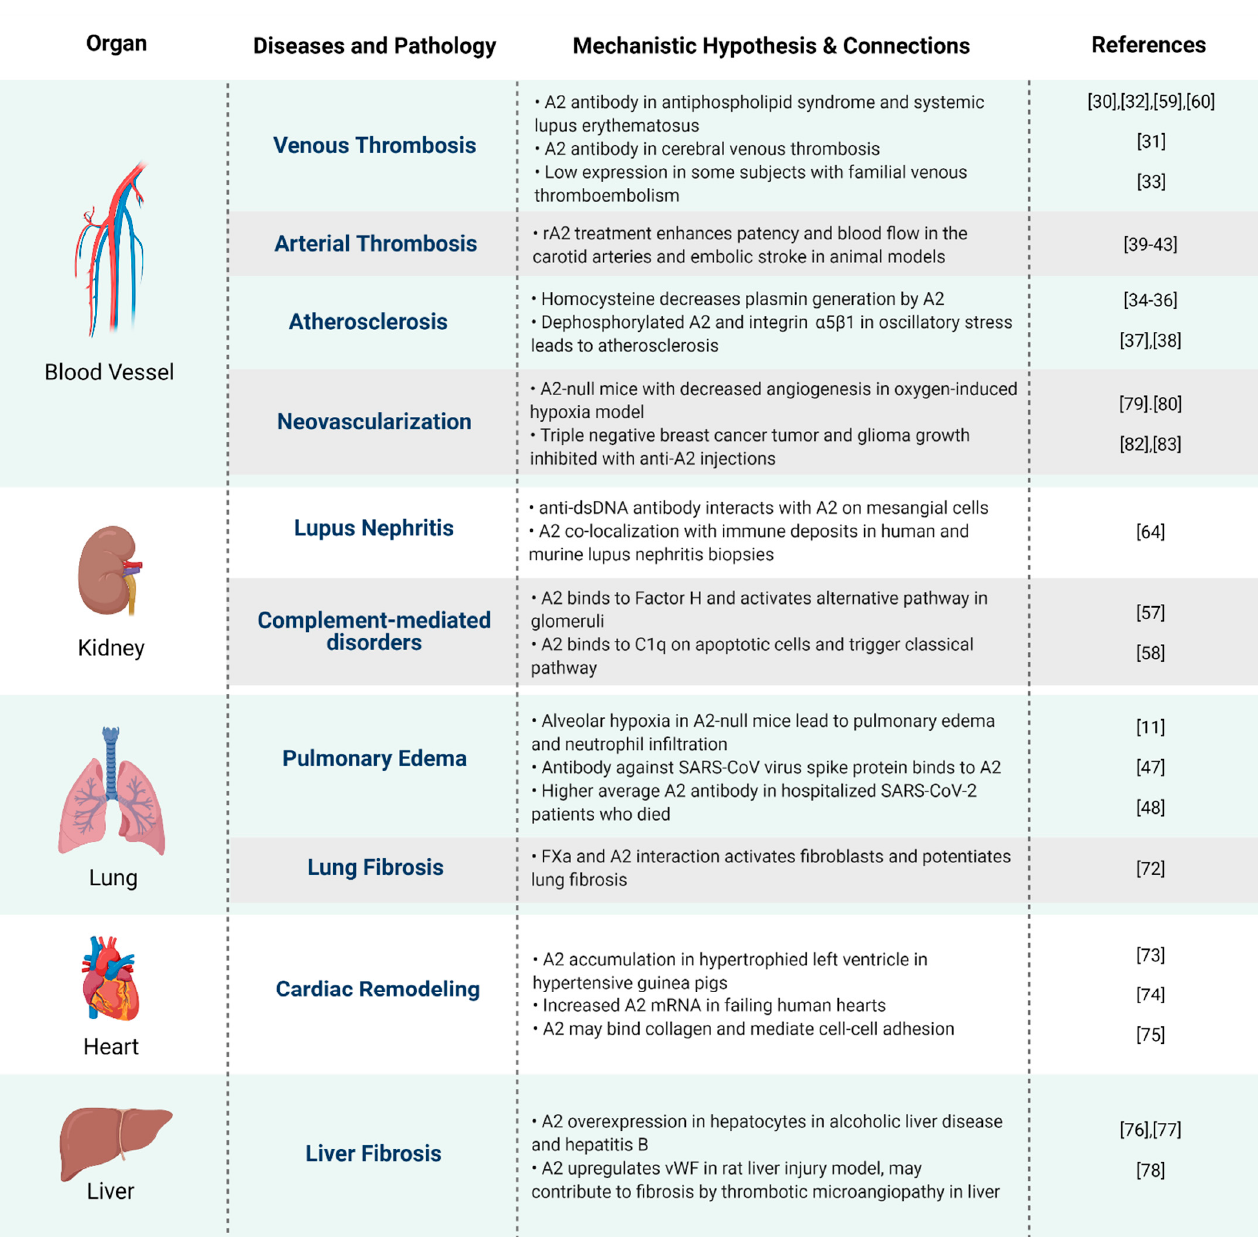
Figure 4. A mechanistic hypothesis and connections between A2 and human diseases. Proposed pathophysiologic mechanisms by which annexin A2 impacts health and disease, organized by a major organ system.